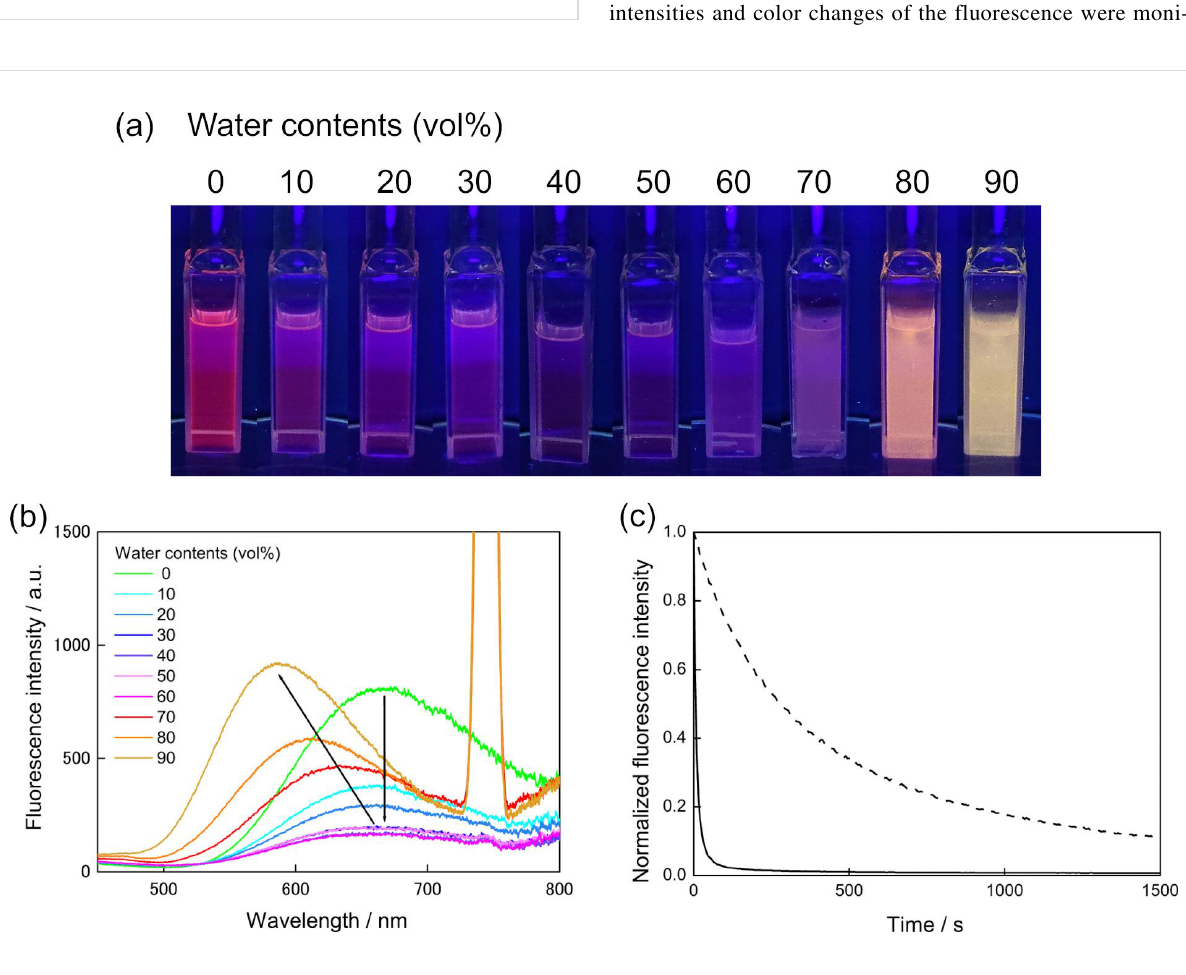
Figure 6: (a) Fluorescence photographs of solutions/suspensions of 1o (1.2×10 -4 M) in THF/water mixtures with different water contents under UV light ( λ = 365 nm) irradiation. (b) The fluorescence spectra of 1o solutions ( λ ex = 370 nm). (c) The fluorescence quenching of THF 100 vol % (water 0 vol %) solution at 670 nm (broken line) and that of THF/water = 10:90 (v/v) at 585 nm (solid line) upon UV irradiation.